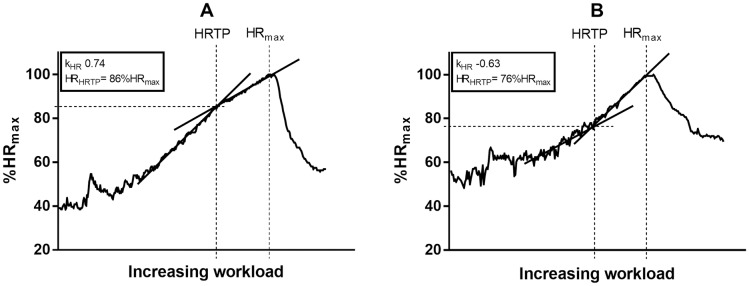
Schematic of the heart rate to performance curve (HRPC) and detection of the heart rate turn point (HRTP) during CPX testing, illustrating a regular HRPC (A) and an inverted HRPC (B).The difference in HRPC translates to a lower heart rate at HRTP (HRHRTP) when given as percentage of the maximum heart rate (%HRmax) (difference 10%). kHR = degree and direction of the heart rate to performance curve. HRmax = maximum heart rate.